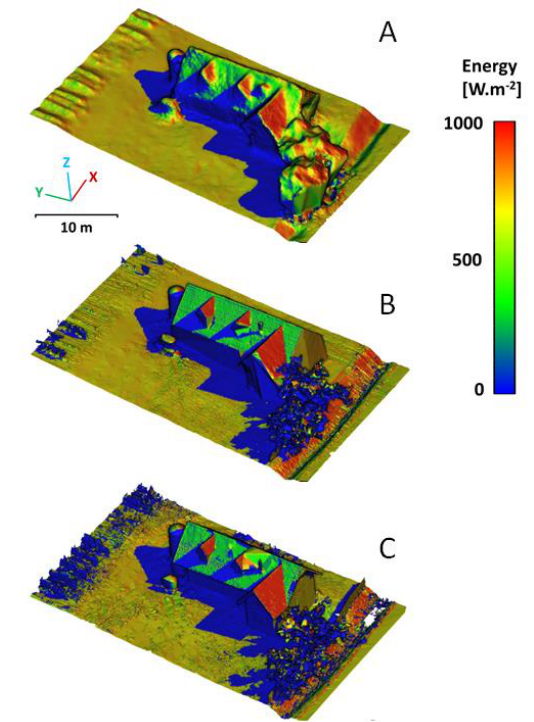
Figure 6. Calculation of solar irradiance for July 15 for a time moment at 10:00, 12:00, 14:00 and 16:00.